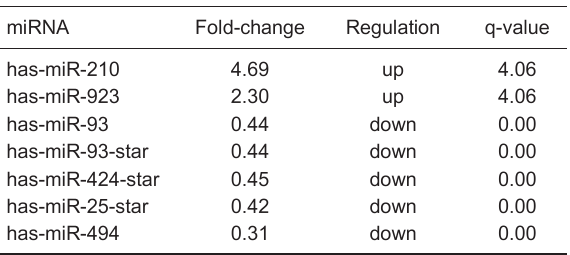
Table 1. Differential expression of miRNAs by Hep-2 and Hep-2/v cells.